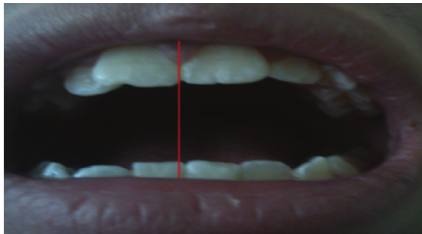
Figure 11: Trismus measurement for a picture concerning a mouth almost closed. The distance of the mouth opening is 2.9707